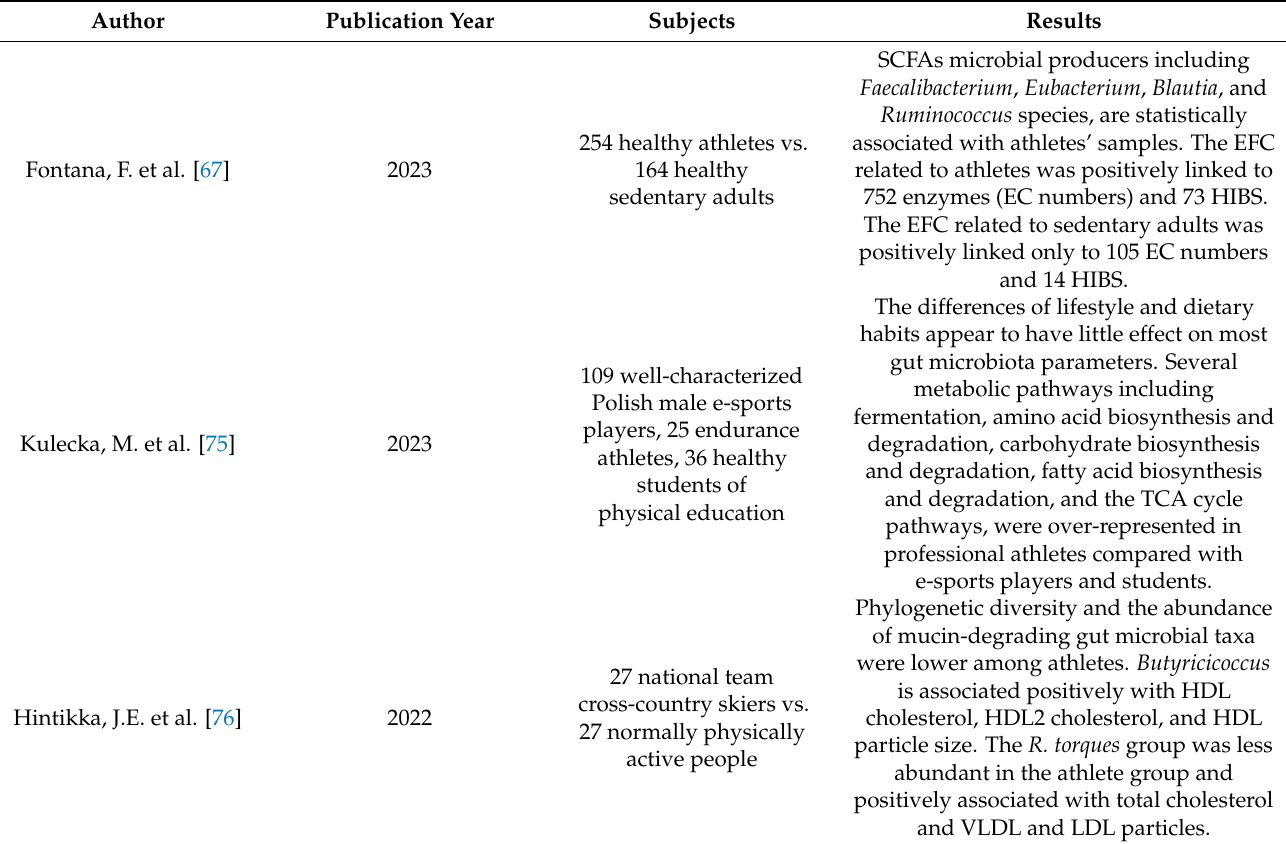
Table 6. Cross-sectional studies in the field of the gut microbiome and